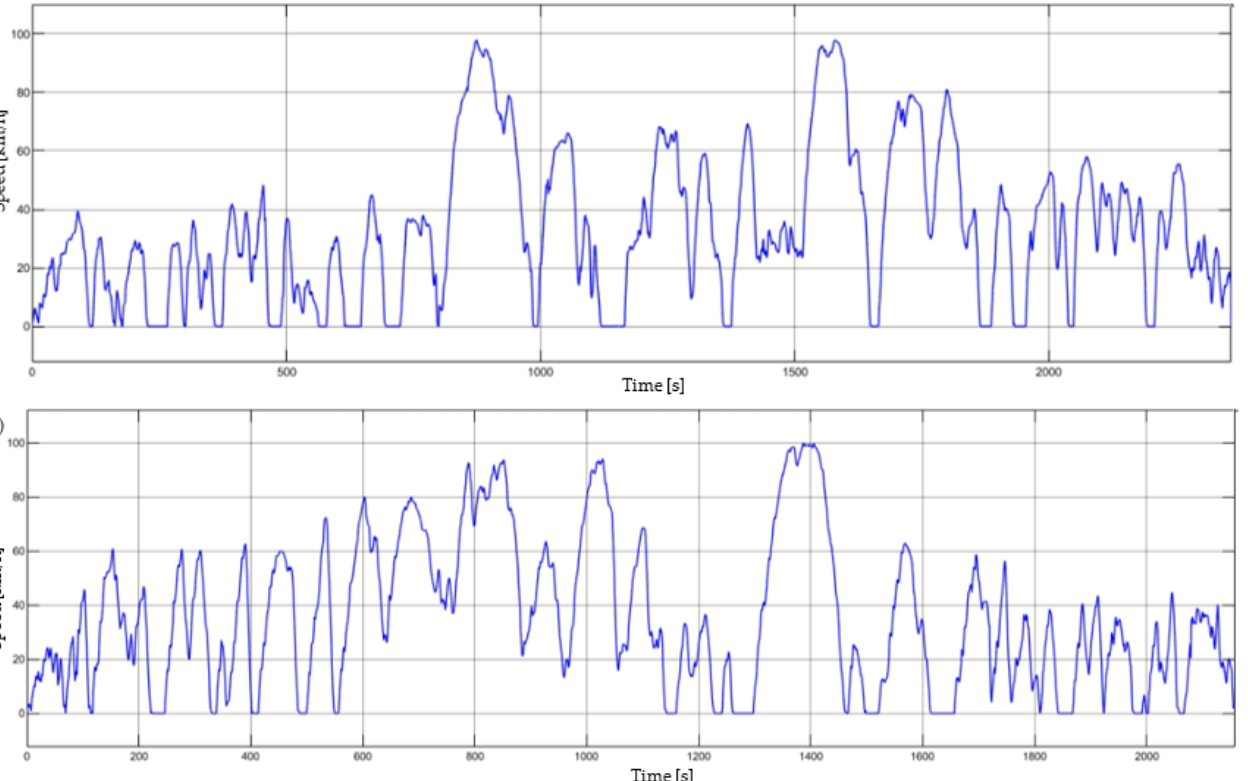
Figure 13. Measured driving cycles: ( a ) Algeciras-La Linea ( b ) La